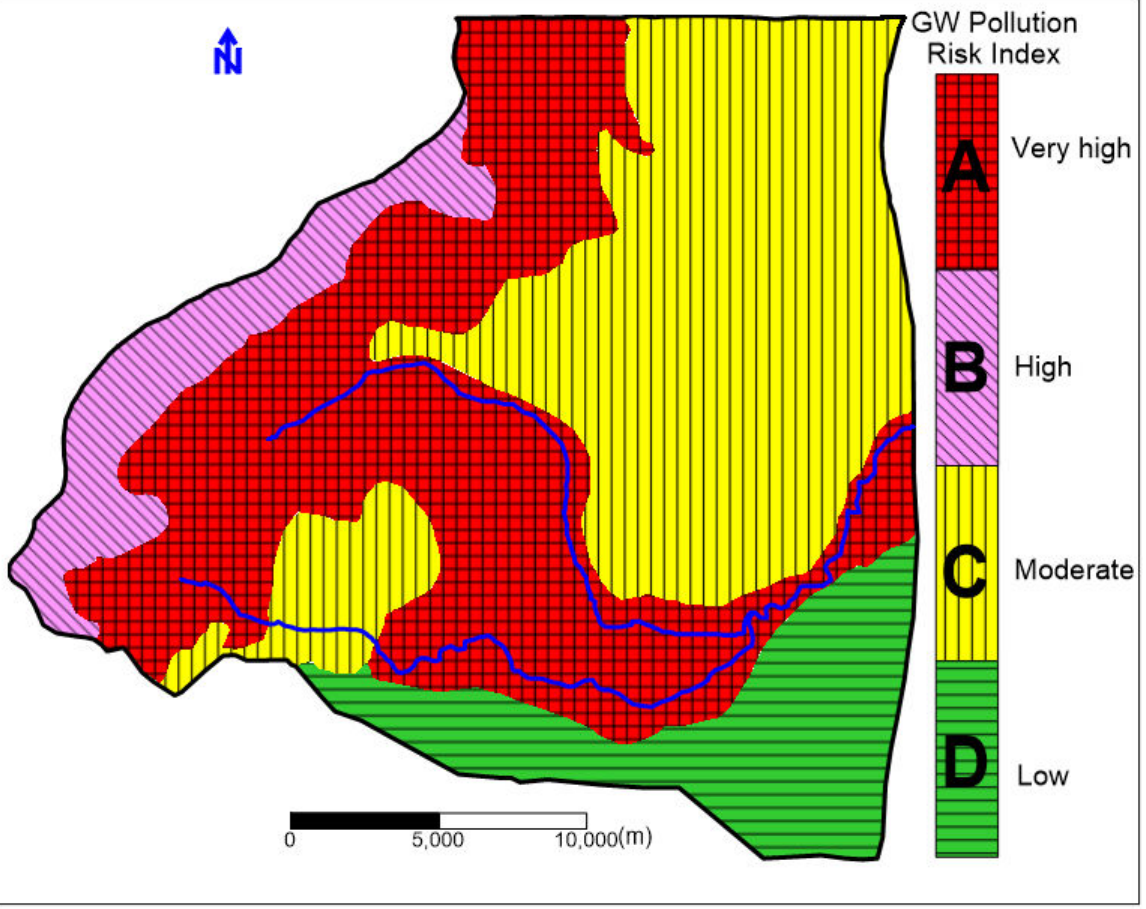
Figure 15. Spatial distribution of simplified groundwater pollution risk index map of NEMH showing the pollution risk